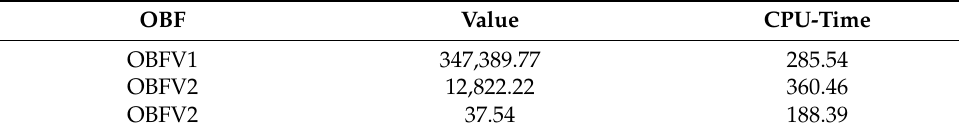
Table 4. OBFV and CPU-time obtained by individual optimization method.